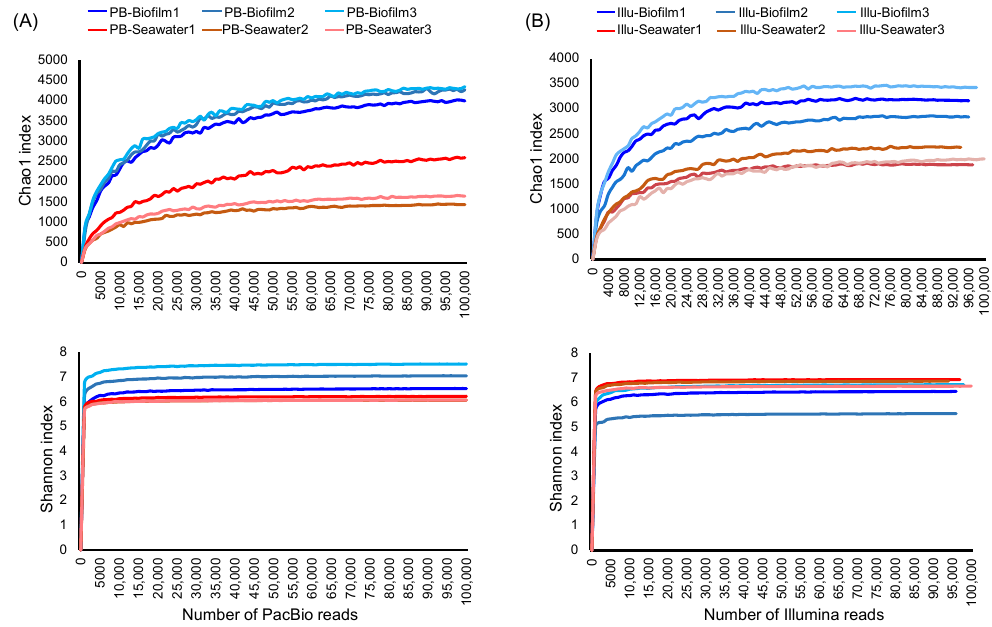
Figure 1. Rarefaction curves showing sequence number and α -diversity correlations. The three bio- film and three seawater samples are indicated by different colors. Chao1 richness and Shannon (H index) diversity were calculated based on the PacBio ( A ) and the Illumina datasets ( B ). For each sample, 100,000 sequences were included for analysis, and the average value of 10 permutations is shown.